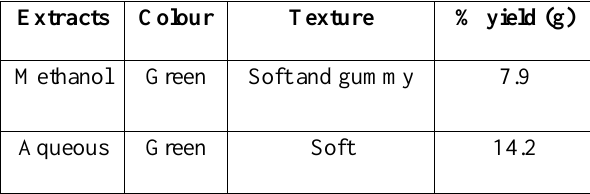
Table 1. Physical characteristics of C.sinensis leaf extracts.